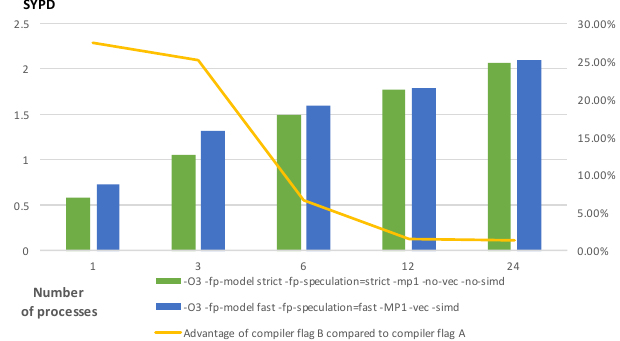
Figure 4. Simulation speed (simulated years per day; SYPD) of CAM5 under two compiler flags (A and B) of Intel compiler version 13 when increasing the number of processes from 6 to 24. The high- performance computer Tansuo100 is used for this test. Compiler flag A ( -O3 -fp-model strict -fp-speculation=strict -mp1 -no-vec - no-simd ) is from the biggest bitwise identical compiling setup sets in Table 8. Compiler flag B ( -O3 -fp-model fast-fp-speculation=fast -MP1 -no-vec -simd ) should be the compiler flag for fastest simu- lation speed. Compiler flag -O3 -fp-model fast -fp-speculation=fast -MP1 -vec -simd should be more aggressive than compiler flag B in compiler optimizations. It is not used in this test because the corresponding simulation run of CAM5 crashes. The advantage of compiler flag B compared to compiler flag A is defined as the per- formance improvement when compiler flag is changed from A to B.